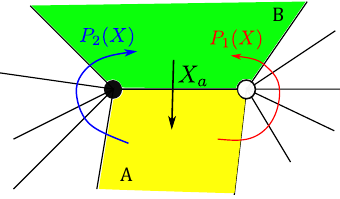
Figure 8. Graphical interpretation of F-term condition of (4.2) in the bipartite graph. The edge connecting the black and white node is dual to the arrow X regions A (yellow) and B (green). The red path asoociated with a monomial P path associated with a monomial P